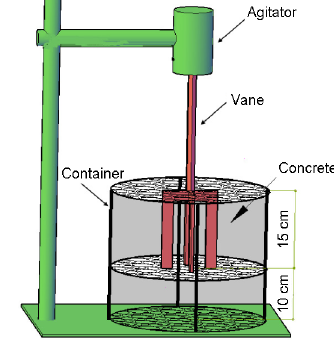
Fig. 2. Rheometer components